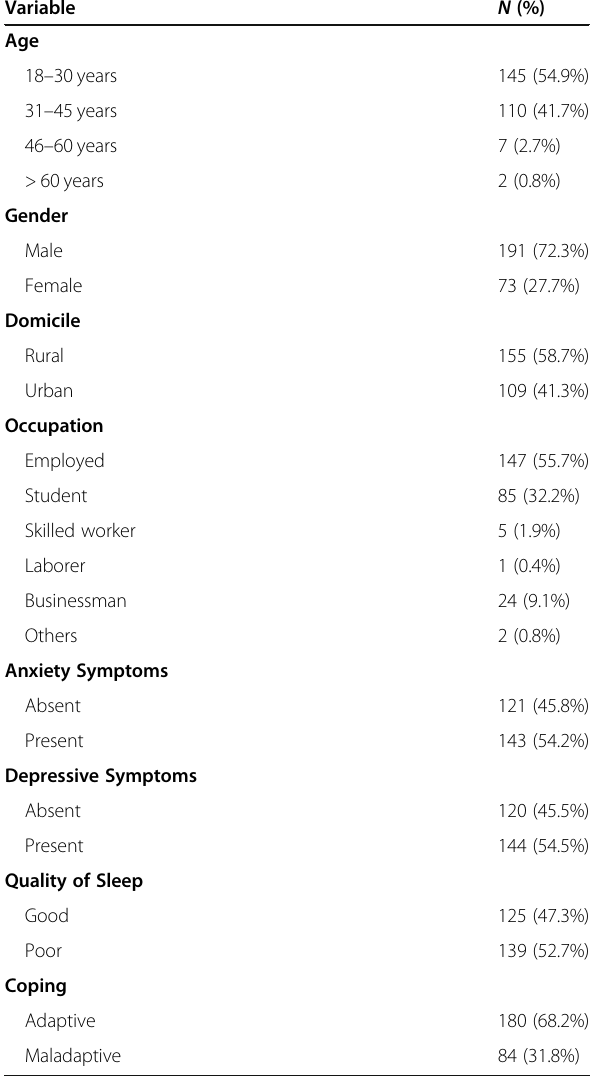
Table 1 Socio-demographic and other variables ( N =